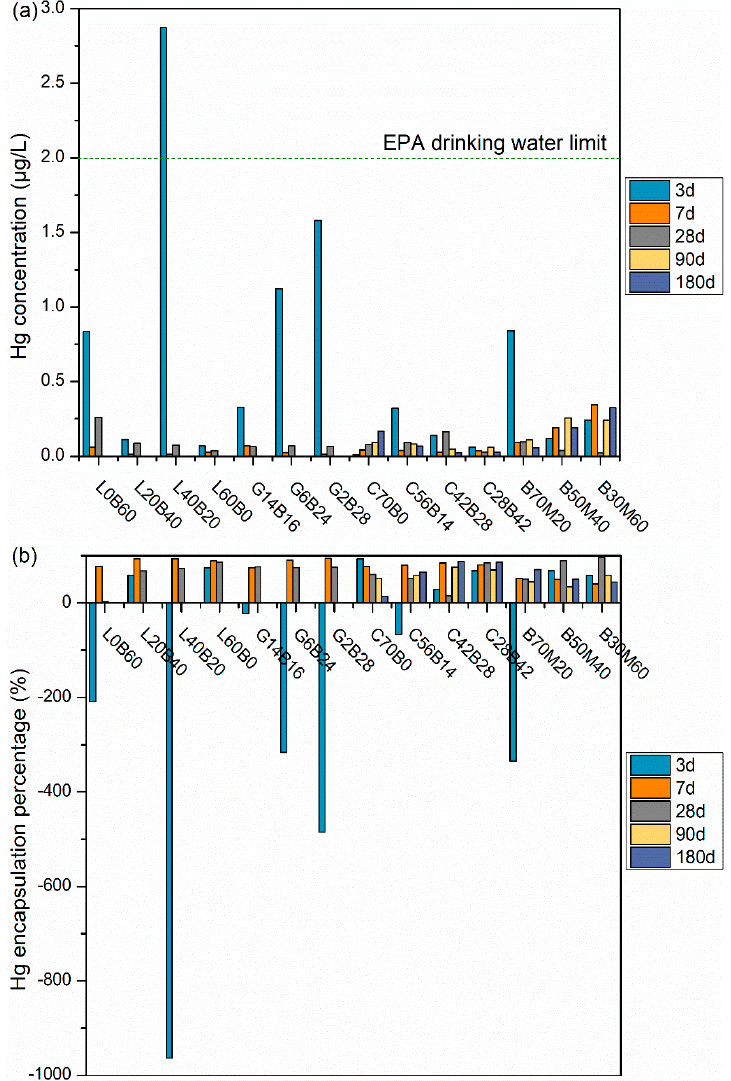
Figure 11. The ( a ) Hg concentration and ( b ) encapsulation percentage for the leachate in all groups at all ages.